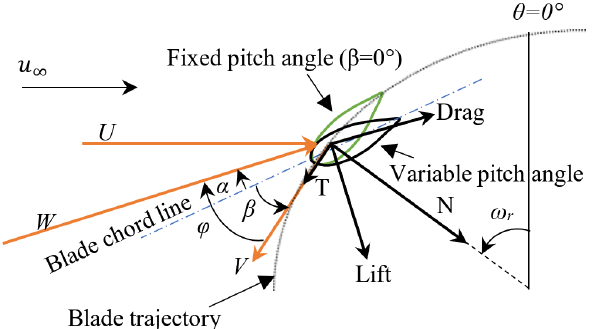
Figure 1. Forces and velocities acting on the blade of a Darrieus